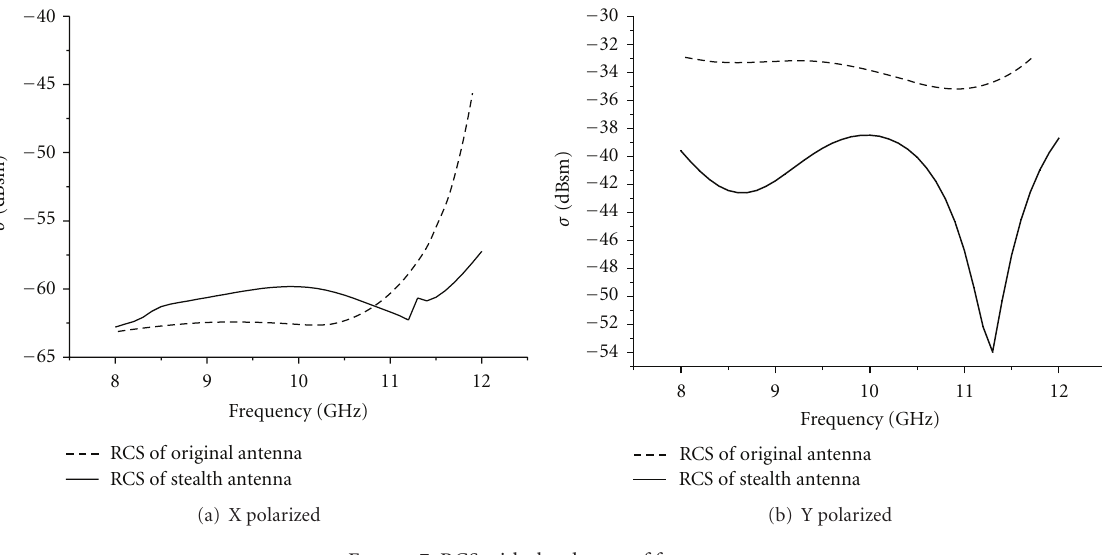
Figure 7: RCS with the change of frequency.